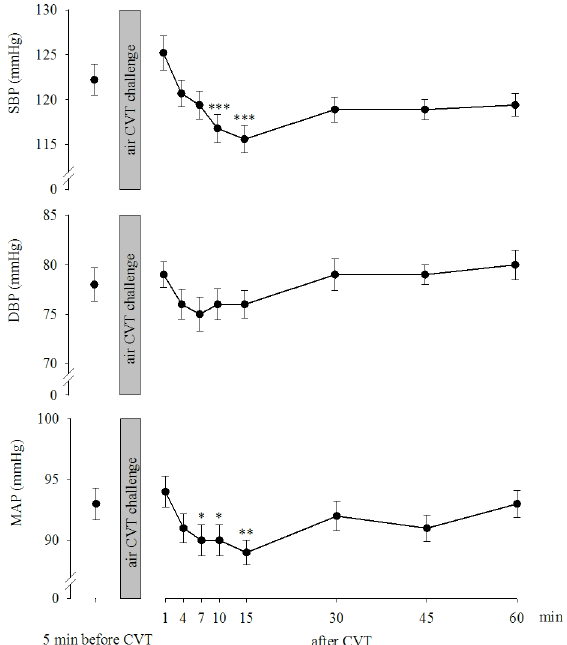
Fig 4. SBP, DBP and MAP before and after the CVT stimulation. Data are expressed as the mean±SE. (cid:3) , (cid:3)(cid:3) , (cid:3)(cid:3)(cid:3) : p < 0.05, p < 0.01 and p < 0.001, respectively, vs before the